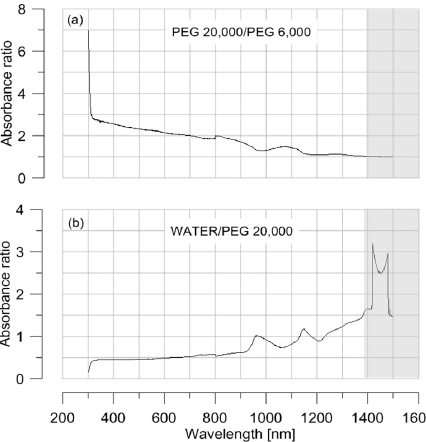
Figure 1. ( a ) Absorbance of the PEG 20,000 solution over absorbance of the PEG 6,000 solution from 300 nm to 1500 nm. Solution concentration is 0.5 g PEG/g water; ( b ) Absorbance of deionised water over absorbance of PEG 20,000 (at 0.5 g PEG/g water) from 300 nm to 1500 nm.